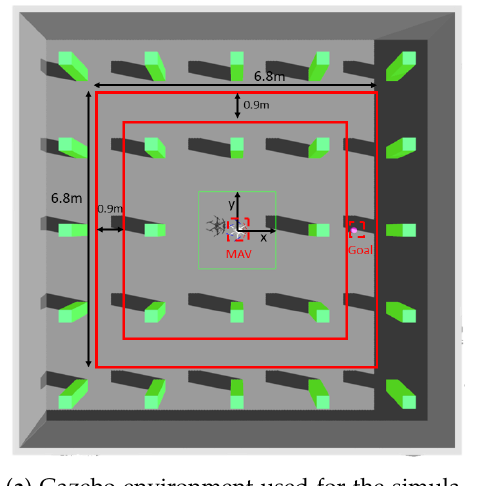
( b ) Example results of the trajectory generated by the OFM of the proposed collision-avoidance method with different initial yaws.